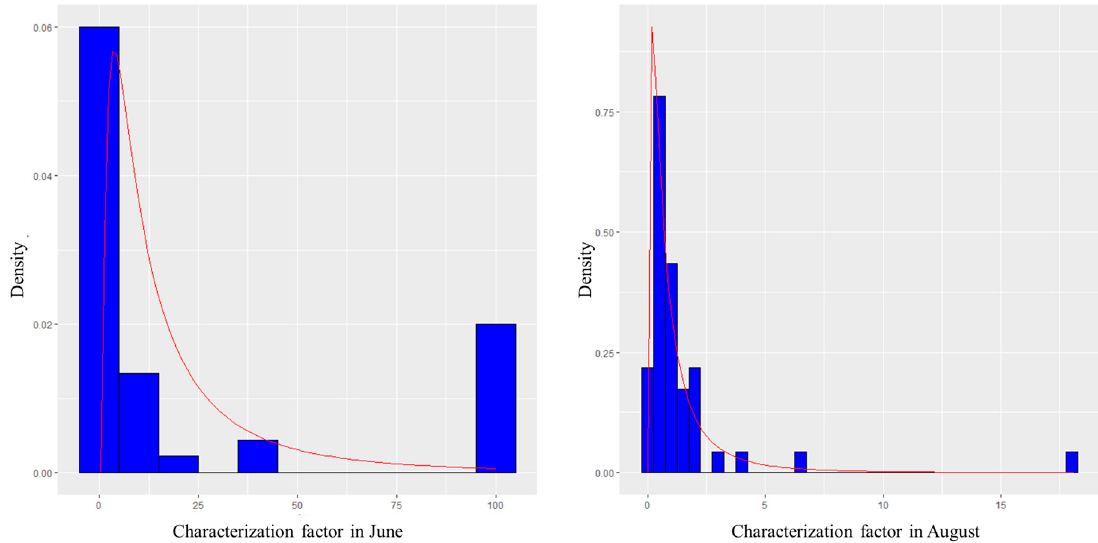
Figure 2. Histogram and adopted lognormal distributions in June and August.